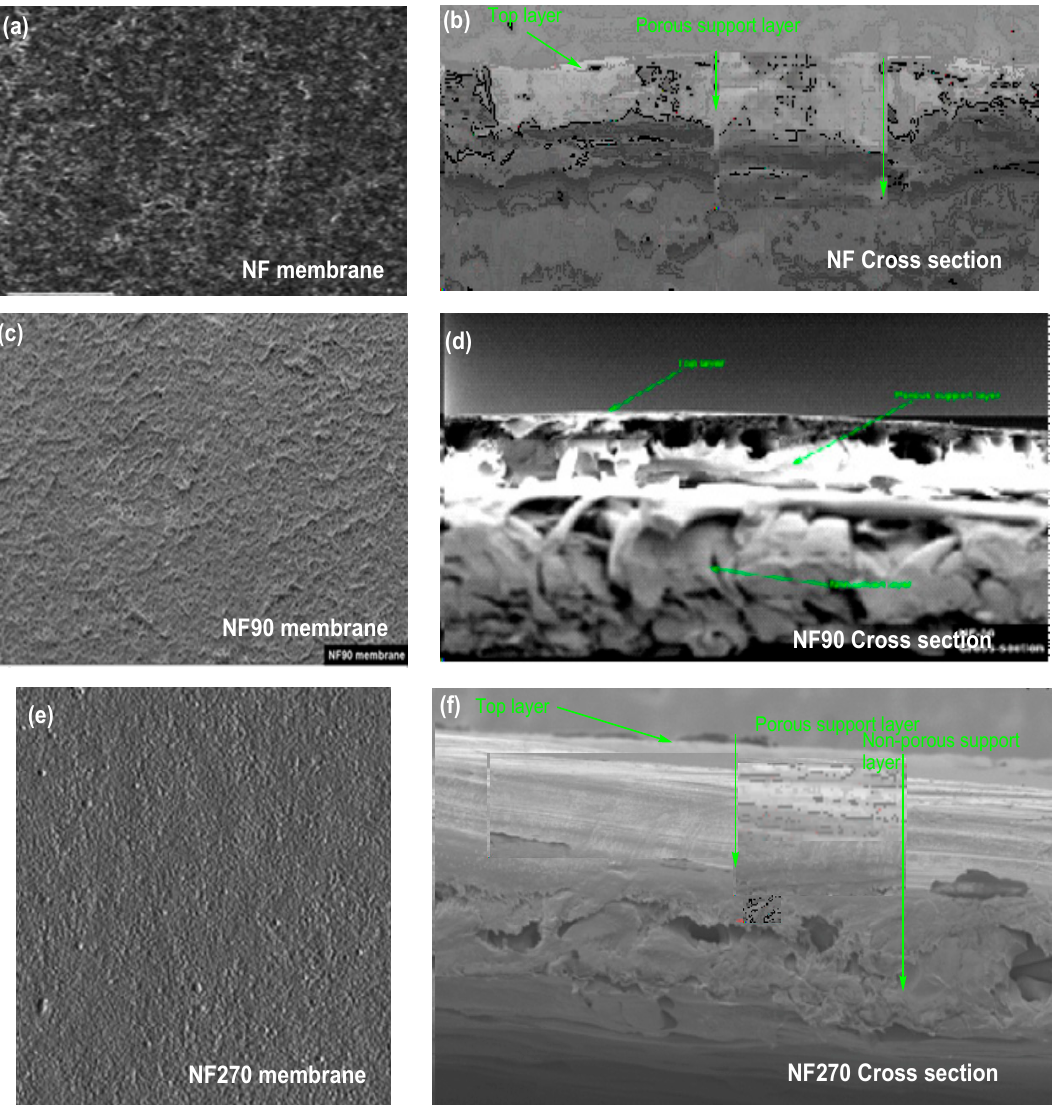
Figure 3. ( a ) NF Top view, ( b ) cross sectional view of NF , ( c ) NF90 Top view, ( d ) cross sectional view of NF90 , ( e ) NF270 Top view and ( f ) cross sectional view of NF90.